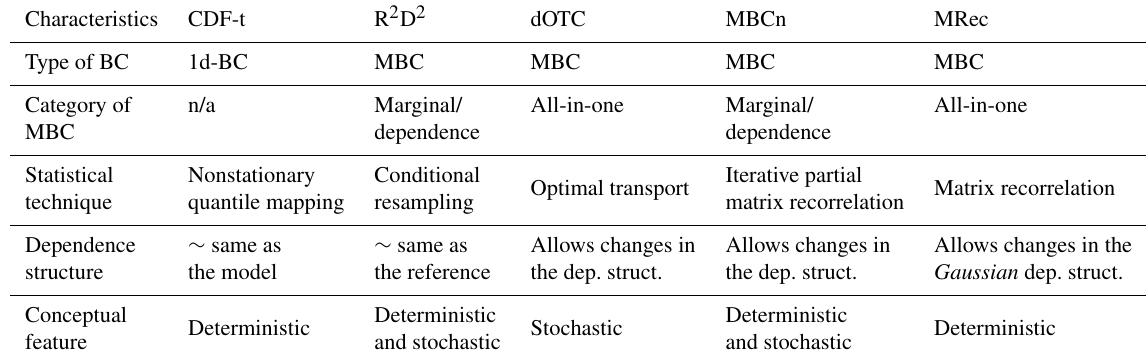
Table 1. Summary of attributes of the different bias correction methods. Not-applicable (n/a) is indicated when the statement in rows does not apply. Characteristics CDF-t R 2 D 2 dOTC